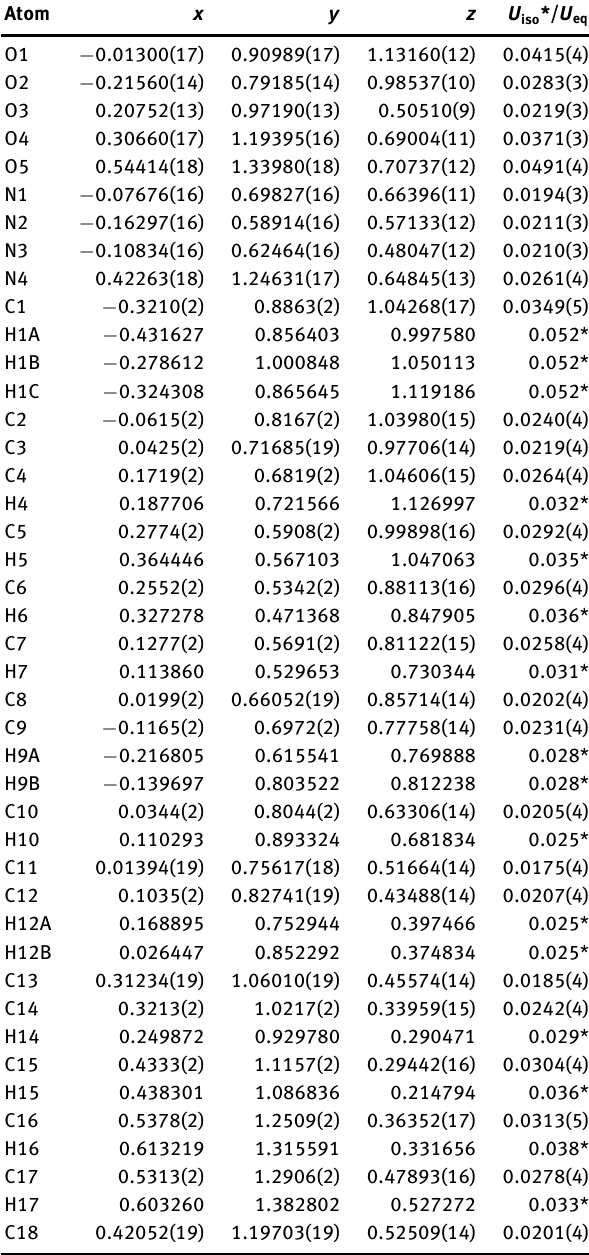
Table 2: Fractional atomic coordinates and isotropic or equivalent isotropic displacement parameters (Å 2 ).